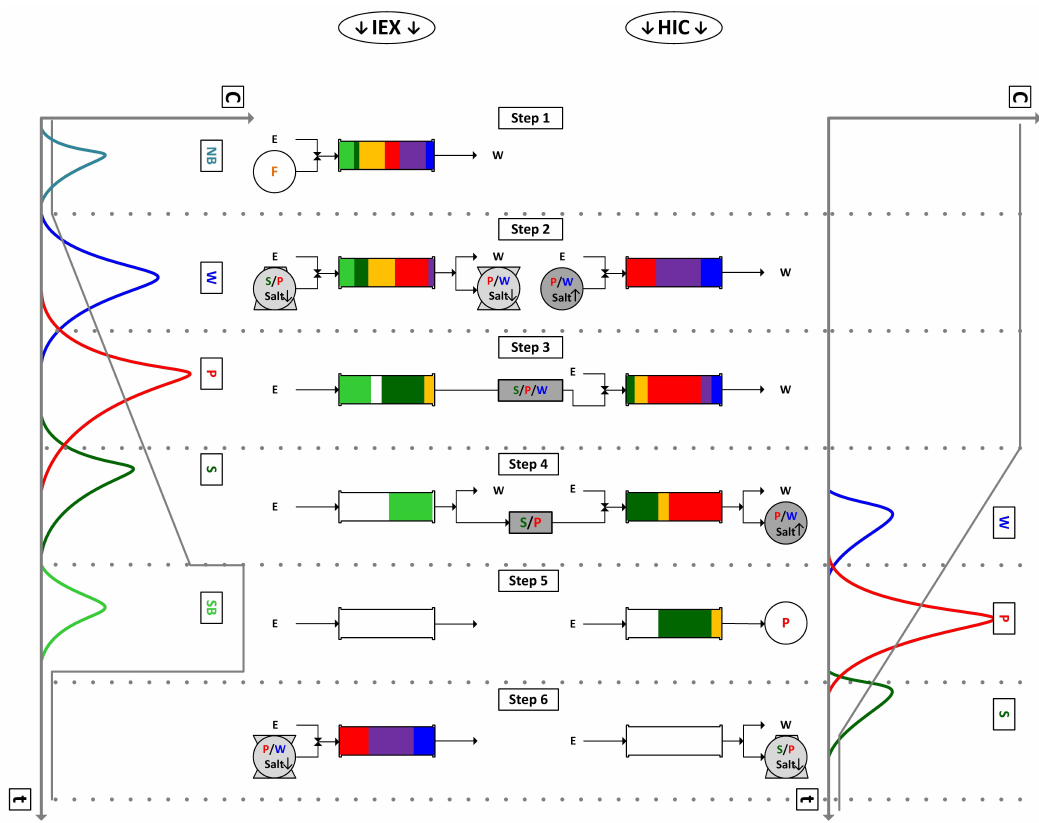
Figure 4. Sequence of an integrated Counter Current Chromatography (iCCC) cycle. IEX, Ion-Exchange Chromatography; HIC, Hydrophobic Interaction Chromatography; NB, Non-Binding; W, Weak-Binding; P, Product; S, Strong-Binding; SB, Stronger-Binding; F,